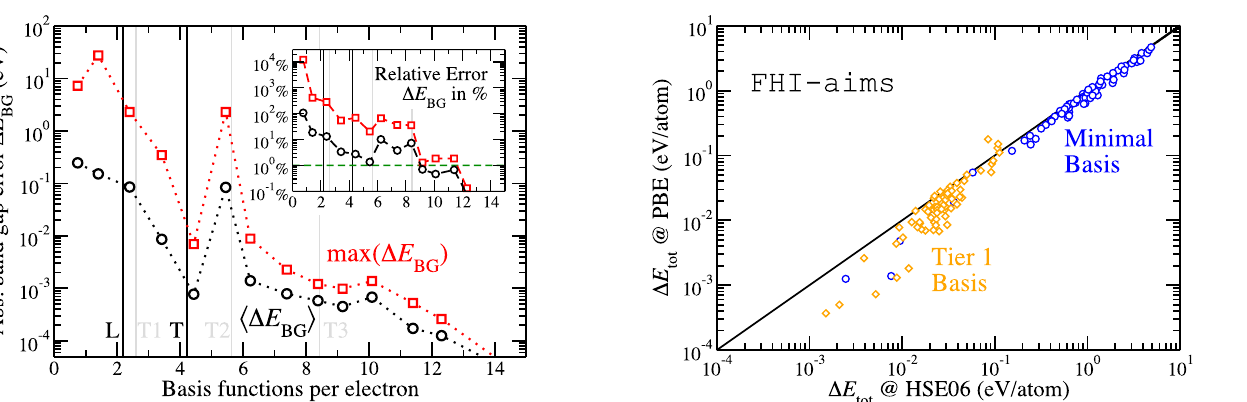
Fig. 7 Correlation of the numerical total-energy errors obtained for the semi-local PBE and the generalized hybrid HSE06 functional. The calculations for the 71 elemental solids are performed with FHI-aims , “ light ” numerical settings, a 2 Å k-point density, and two different basis sets (minimal, “ Tier 1 ”